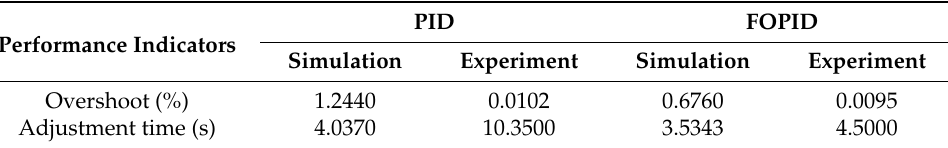
Table 6. Comparison of PID algorithm and FOPID algorithm in 50% opening step input simulation and